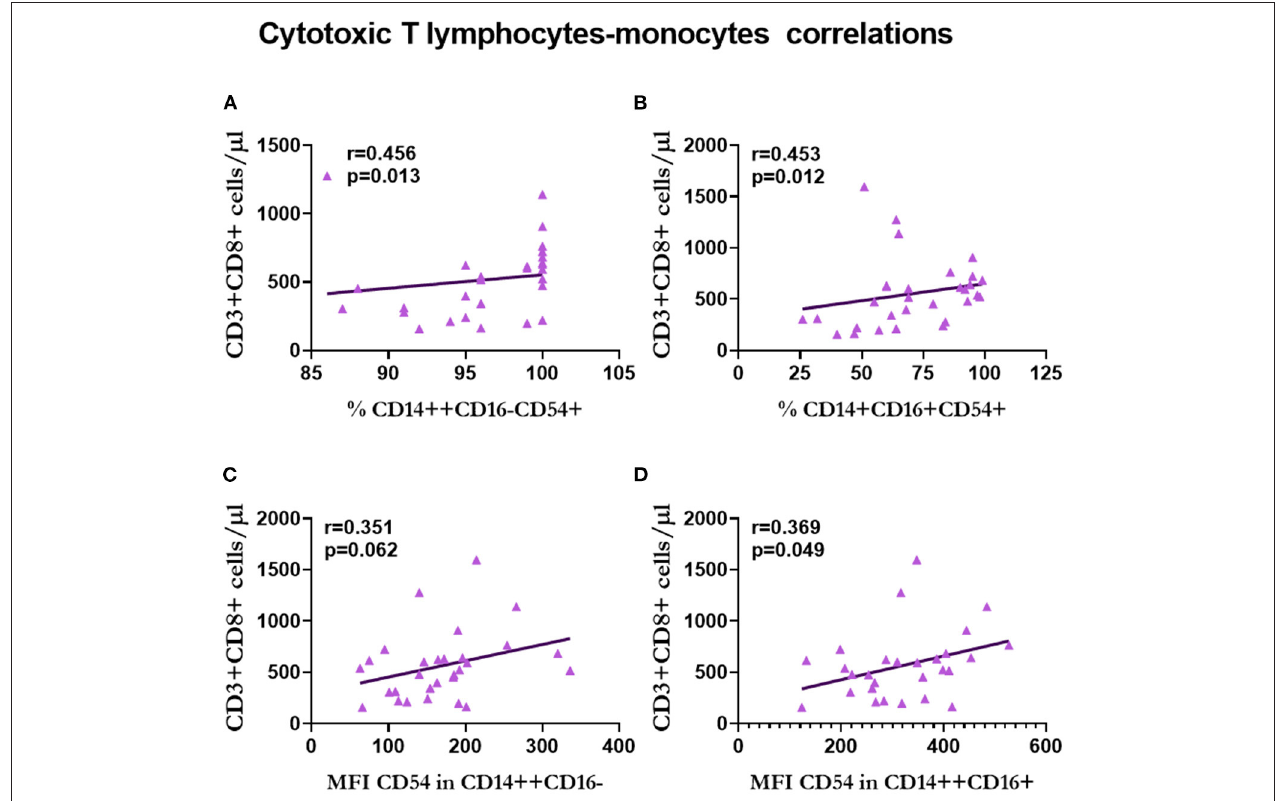
FIGURE 11 | Correlation between T-cytotoxic lymphocytes and monocytes in renal transplantation. Correlations between T-cytotoxic lymphocytes and the percentage of classical (A) and non-classical (B) CD54 + monocytes, and the expression of CD54 in classical (C) and intermediate (D) monocytes are shown.